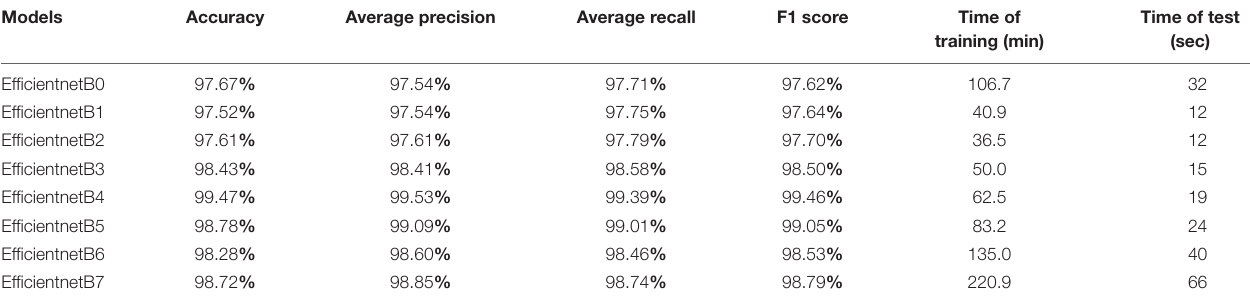
TABLE 6 | Evaluation performance on the validation sets for EfficientnetB0-B7. Models